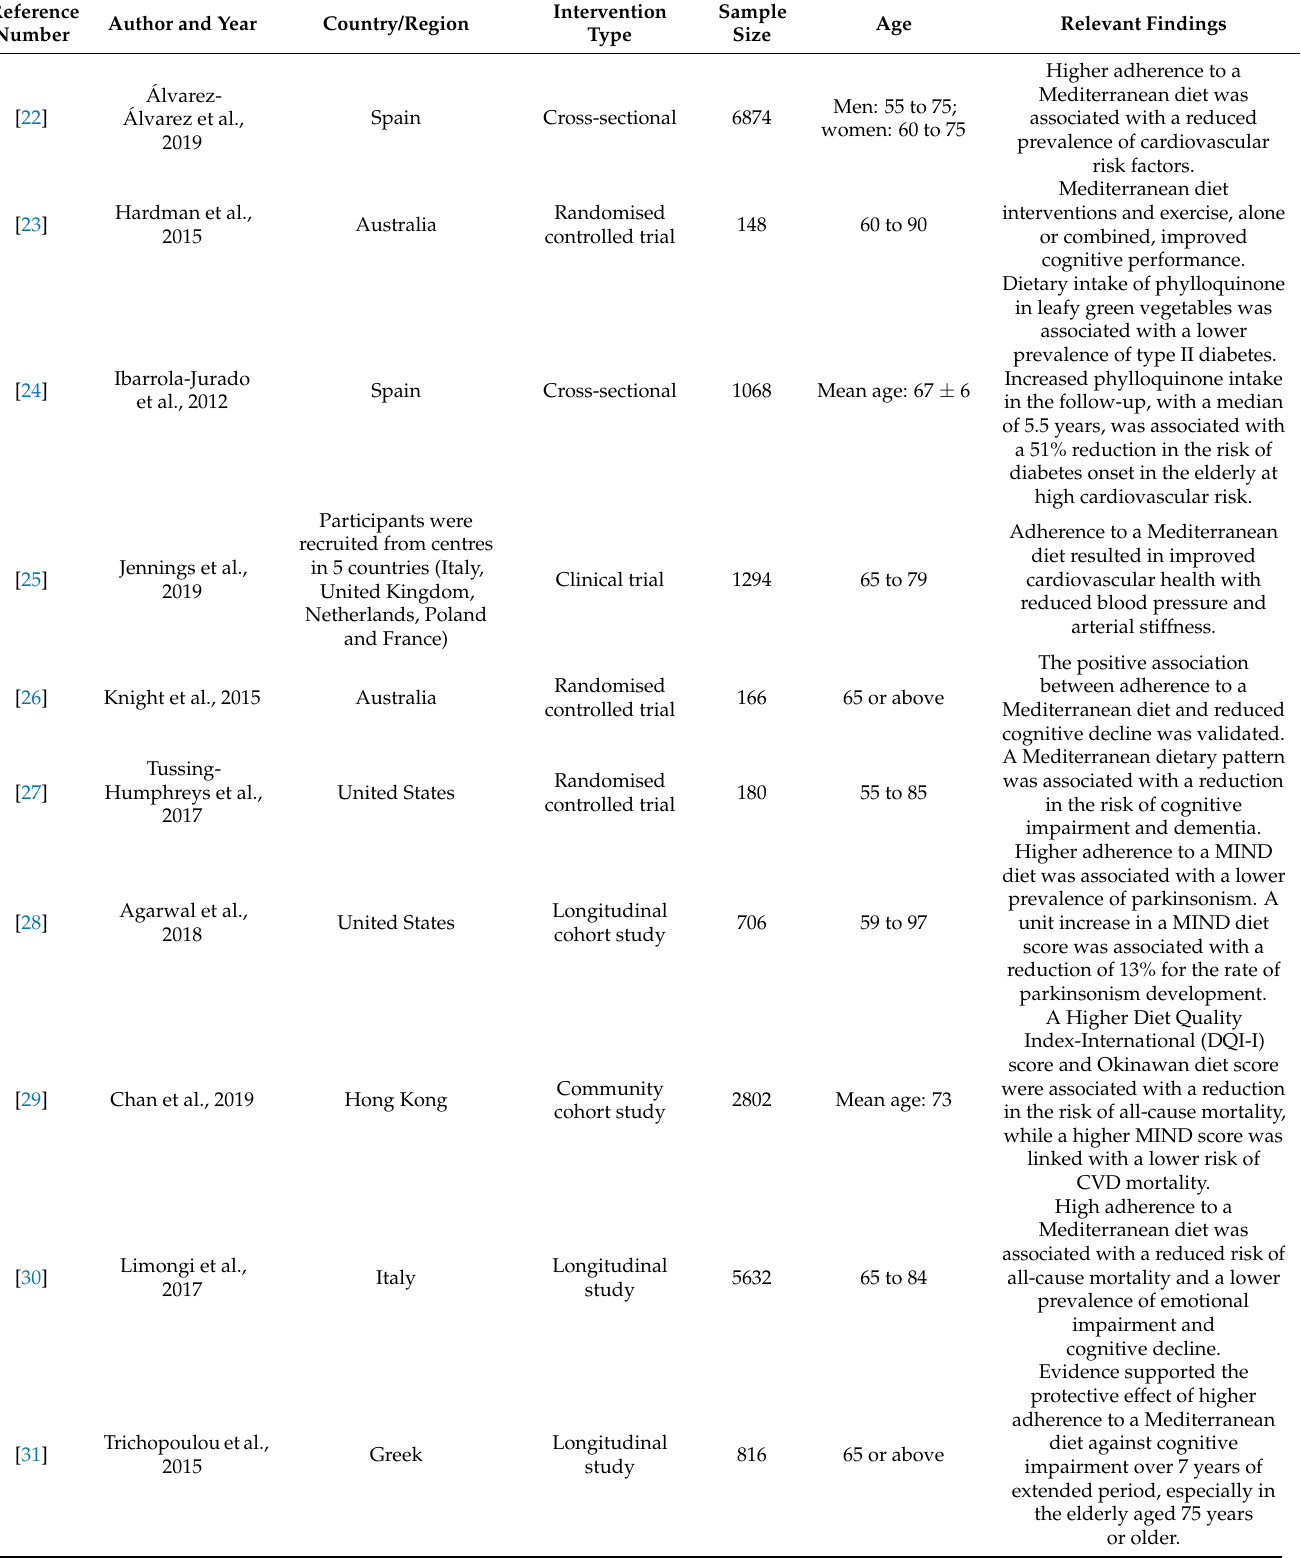
Table 1. Summary table of studies investigating the dietary pattern and health effects among the